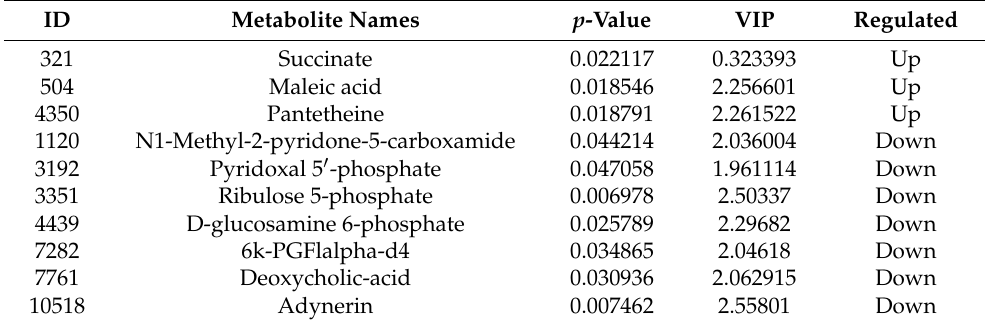
Table 3. Partially different metabolites of the colon contents in the spermidine-treated and control